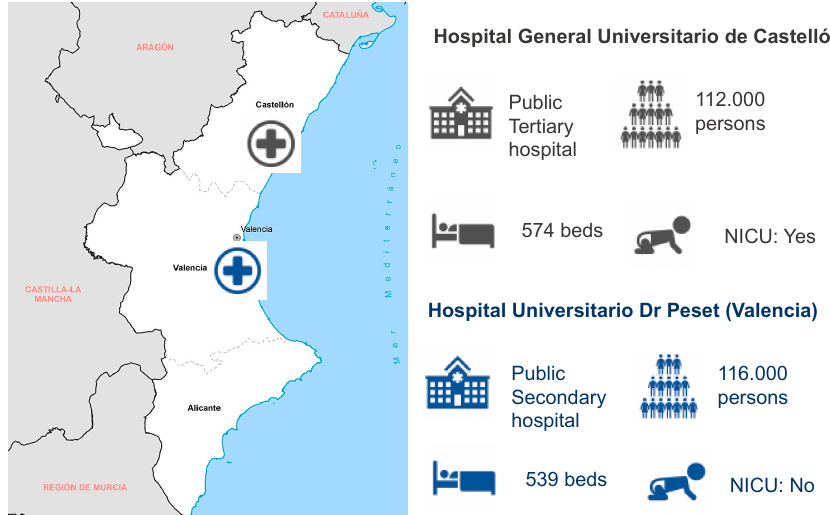
Figure 1. Geographic situation and characteristics of the two participant hospitals in the Valencia Region (Hospital General de Castellón and Hospital Universitario Dr. Peset): facility ownership, catchment population, number of beds, and presence of a neonate intensive care unit (NICU).